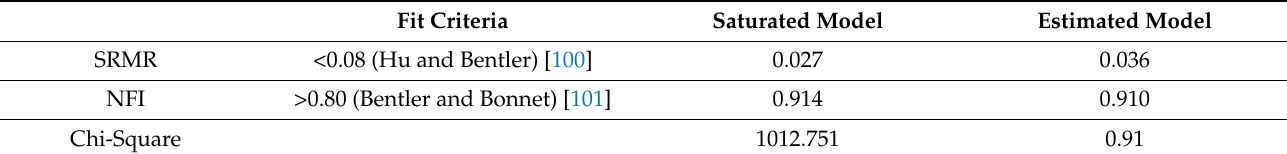
Table 8. Model Fit.